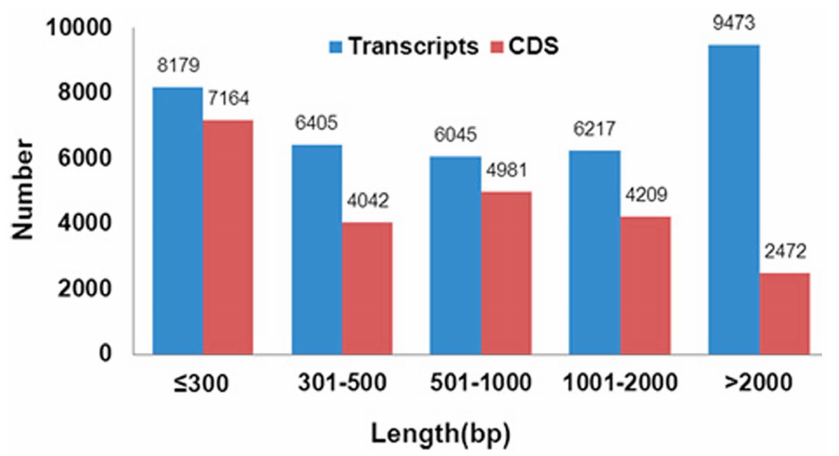
Figure 1. Size distribution of the transcripts and CDSs. The blue and red bars indicate unigenes and CDS, respectively. doi:10.1371/journal.pone.0087800.g001 Protein Domains